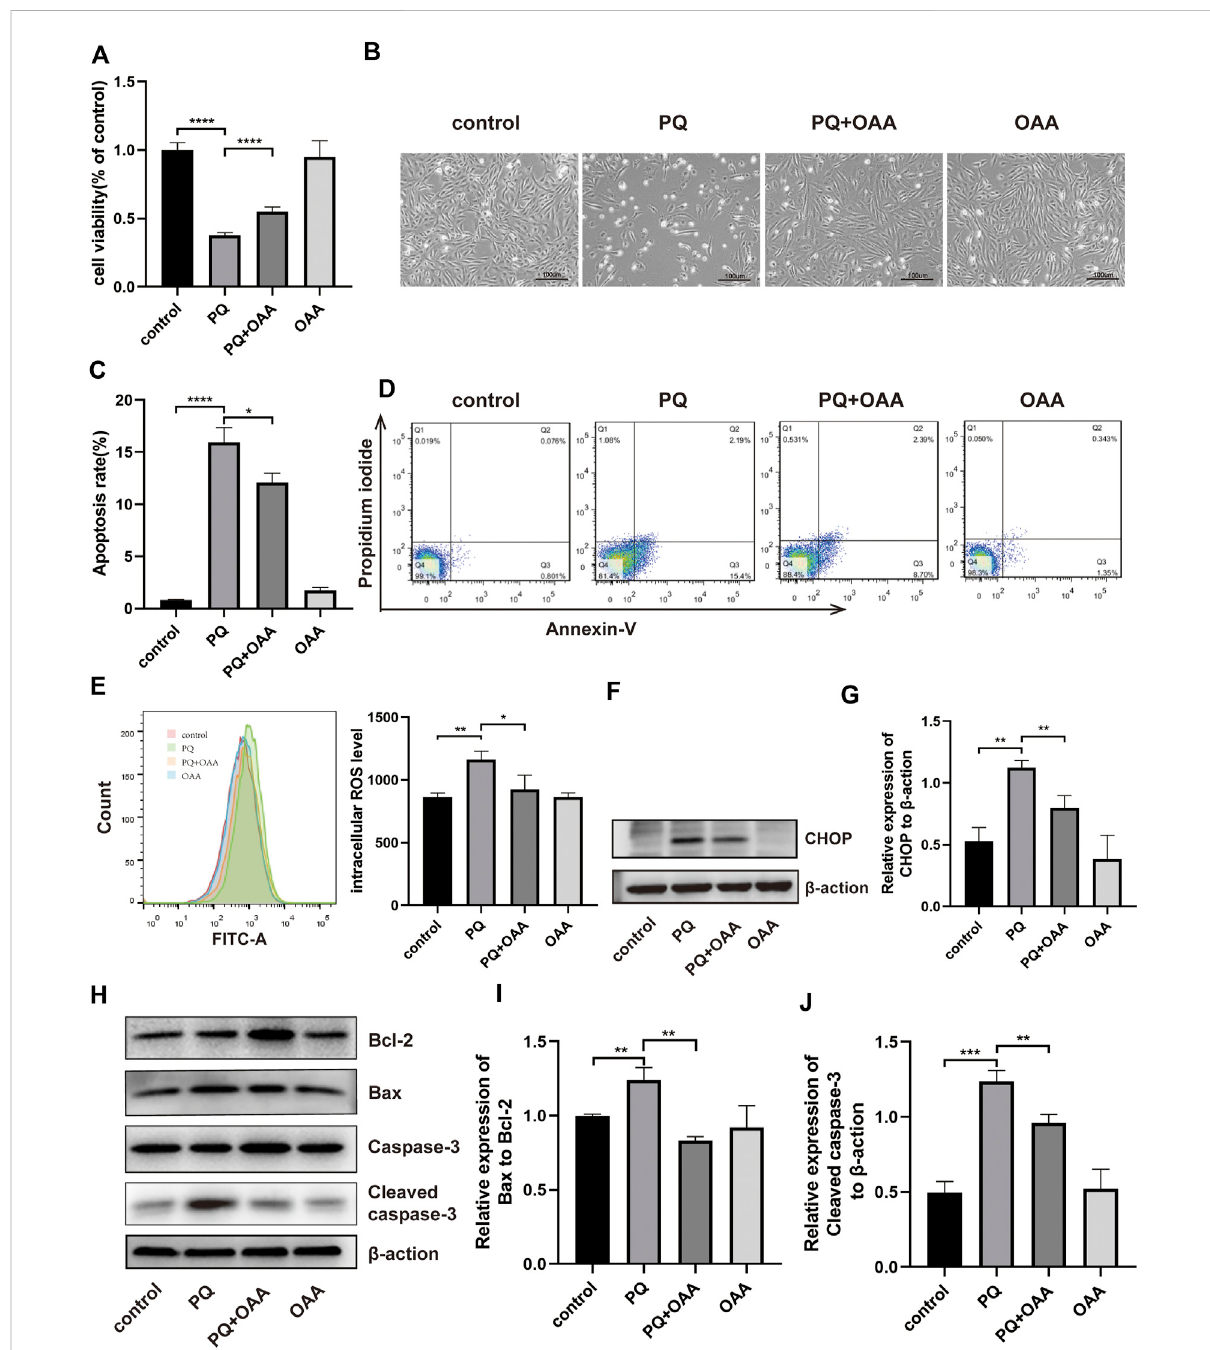
FIGURE 3 OAA alleviates PQ-induced cytotoxicity, apoptosis and oxidative stress in B2B cells. (A) The cell viability was evaluated by CCK-8 assay. (B) Morphological changes of B2B cells under the optical microscope. (C,D) Cell apoptosis was detected by fl ow cytometry. (E) Intracellular ROS levels was measured by fl ow cytometry. (F,G) The expression levels of CHOP protein was detected by WB assay. (H – J) The expression levels of Bcl2, Bax, Caspase-3 and Cleaved Caspase-3 protein was detected by WB assay. Data are presented as mean ± SD ( n = 3). * p ＜ 0.05, ** p ＜ 0.01, *** p ＜ 0.001, **** p ＜ 0.0001. PQ, paraquat; OAA, oxaloacetate